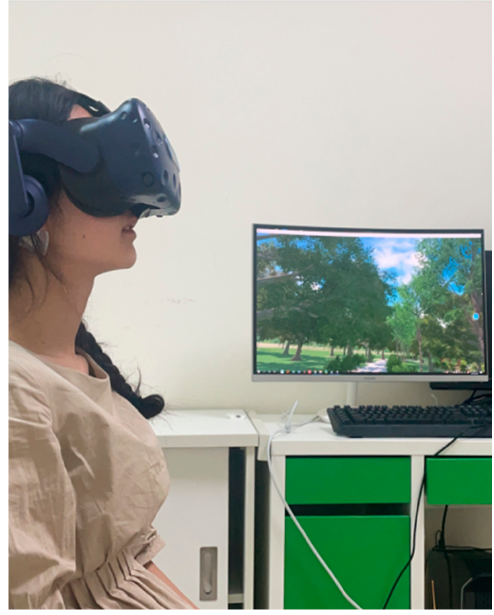
Figure 12. Experiment scene schematic 2.